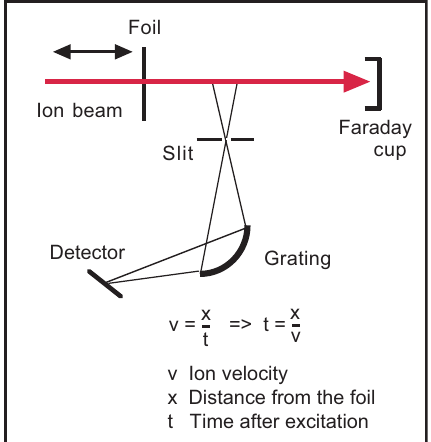
Figure 1. Schematic of the experimental arrangement of beam–foil spectroscopy. In the present measurements, the width of the spectrometer field-of-view at the position of the ion beam corresponds to a time window of about 90ps width. The foil was displaced (along the ion beam trajectory) by up to 10cm, corresponding to a time-of-flight of the ions of up to 10ns after excitation. At the ion beam energy of 20 MeV in the above example, the charge state distribution after passage through the exciter foil has a maximum near q = 13 + (the charge state distributions refer to the investigations by Shima et al. [40]). This would correspond to the K-like spectrum of Ge, Ge XIV. However, while this spectrum (in the EUV) has not yet been studied by beam–foil spectroscopy, the extension of the Bochum group’s preceding work on ions of the iron group elements (see [36,37]) called for higher charge states which required higher ion beam energies, which in turn required higher charge states than q = 4 + from the gas stripper in the accelerator high voltage terminal. Actually, the highest charge state for which an ion beam fraction was large enough to yield a practically useful detector signal (after charge-state modification and excitation of the fast ions in the passage through the foil) behind the exit slit of the spectrometer was q = 8 + , with an ion beam energy of 36 MeV. At this energy, the Shima tables [40] indicate a maximum charge state after ion–foil interaction of q = 15 + (Cl-like), with charge state fractions that might suffice for an observable signal for q = 18 + (Si-like) to q = 12 + (Ca-like). (The earlier measurements on Zn ( Z = 30) (see [36]) had been limited to ion beam energies of 22 MeV and 28 MeV, respectively, because the ion source output for Zn had been so much lower that the charge state fraction q = 6 + from the accelerator had been the highest one useable.) For 36 MeV Ge ions the beam current (particle current) amounted to about 0.03 µ A, which was barely sufficient for recording meaningful